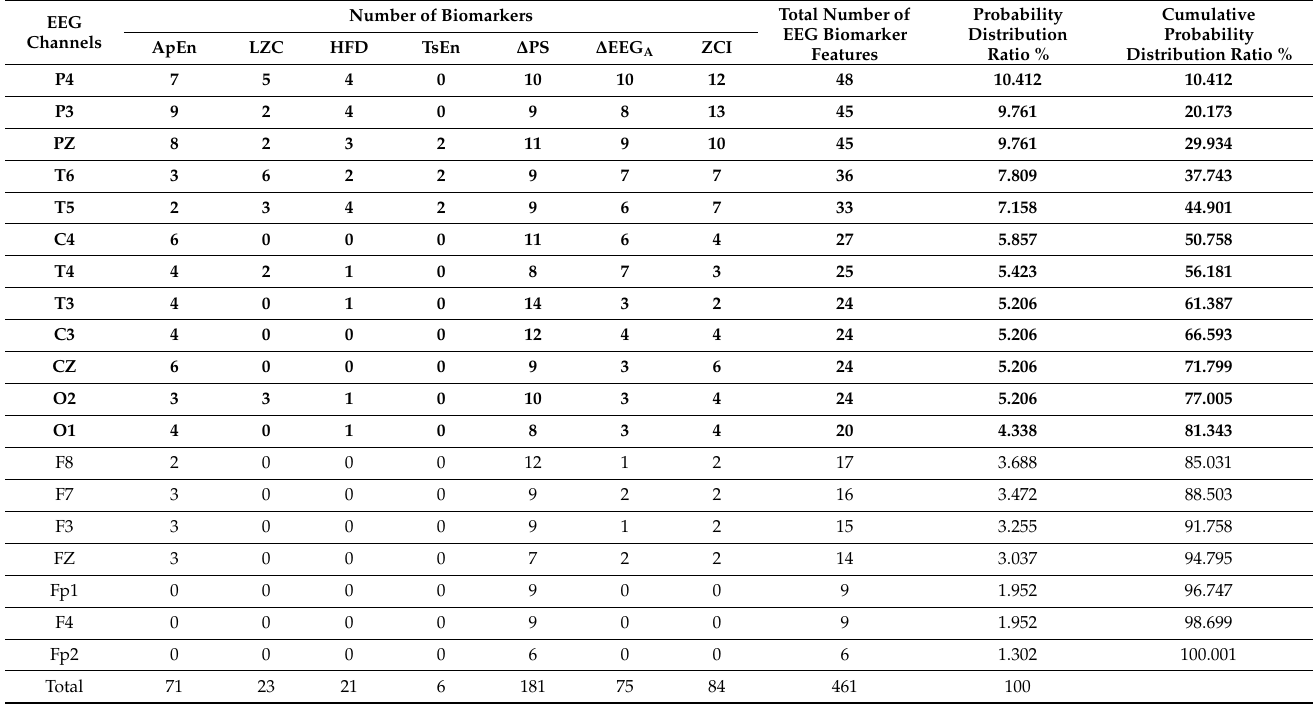
Table 4. Probability distribution ratios for all 25 EEG biomarker features and for all 19 EEG channels. EEG